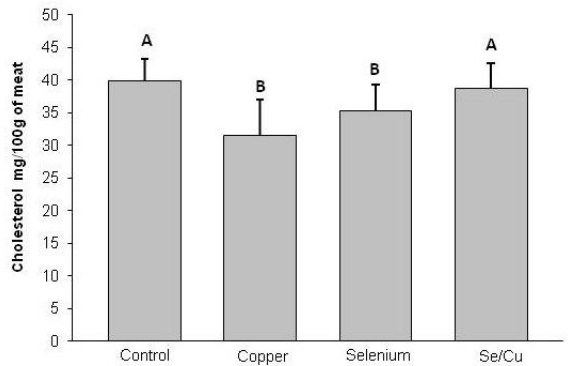
Figure 1. Concentration of cholesterol and standard deviations in mg per 100 grams of meat, in the Longissimus dorsi muscle of cattle receiving control diet (without supplementation of selenium and copper), copper (40 mg/kg of DM), selenium (2 mg/kg of DM), or selenium (2 mg/kg of DM)/copper (40 mg/kg of